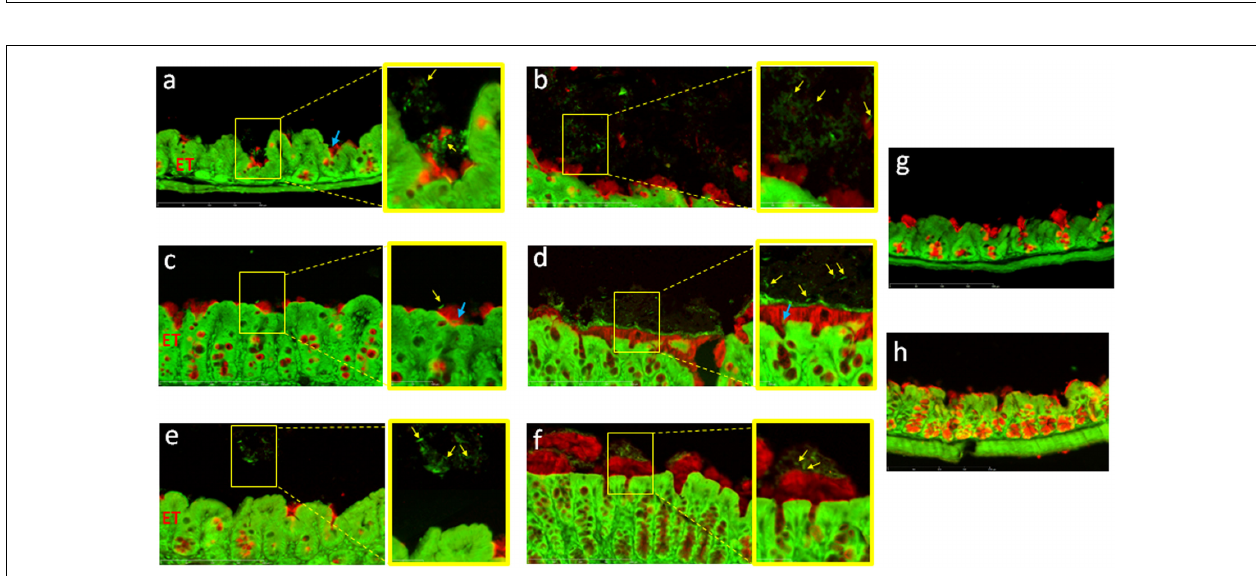
FIGURE 3 | Clostridium difficile cells are mainly localized at the surface of the mucus layer. Immunodetection of mucus and fluorescent labeling of bacteria by SYTO R (cid:13) 9 in the cecum (a,c,e,g) and in the colon (b,d,f,h) of mice infected with strains 630 (cid:49) erm (a,b) , R20291 (c,d) , P30 (e,f) , or in axenic mouse (g,h) . Mucus is stained in red and DNA (bacterial, eukaryotic intracellular and, extracellular DNA) is stained in green. The right panel is the enlarged section of the yellow boxed portion of the image. Yellow arrows indicate position of bacteria outside the mucus layer. Blue arrows indicate position of bacteria in the outer layer of mucus. Scale bar is 200 µ m.